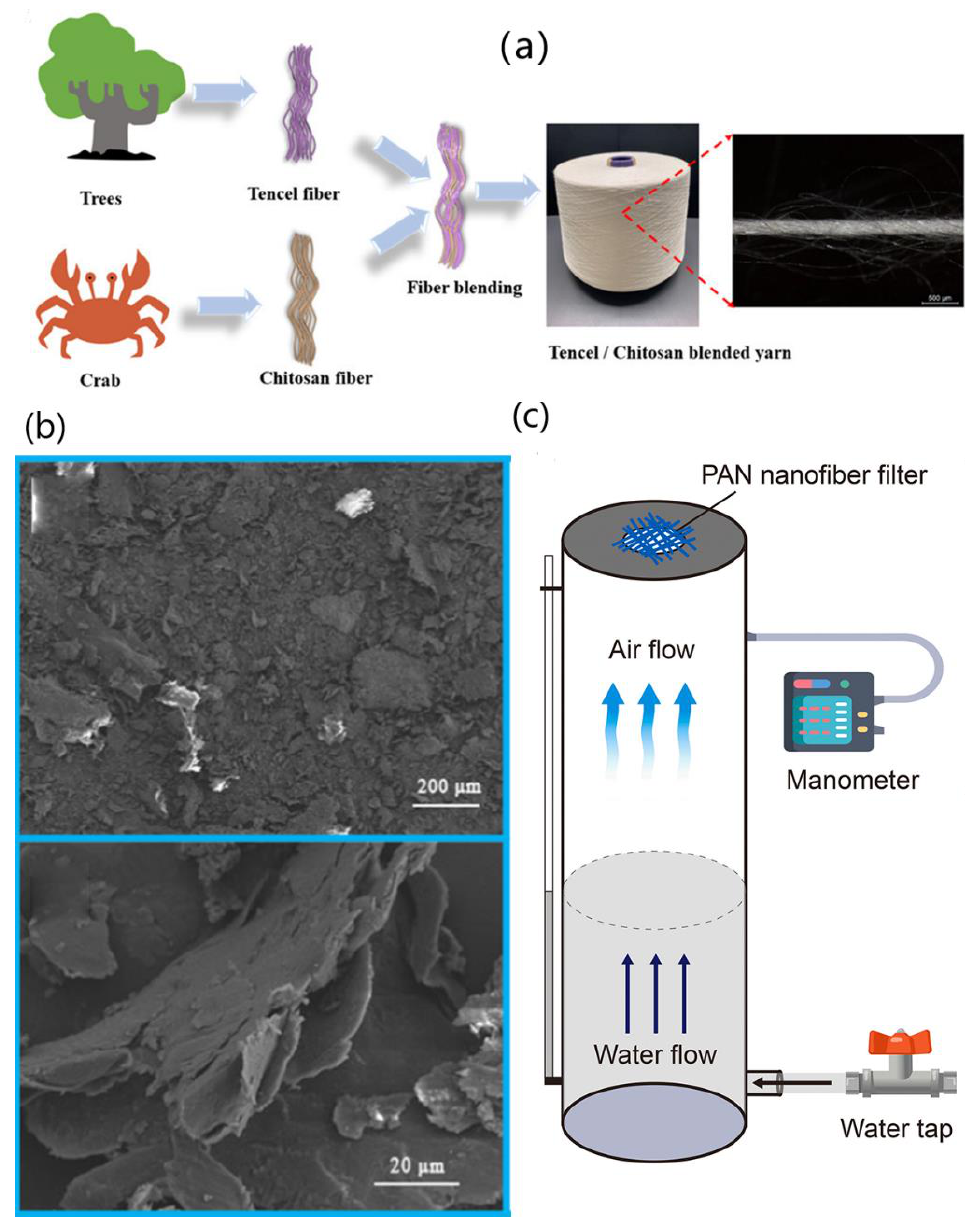
Figure 4. ( a ) Images showing the morphologies of the Tencel/chitosan yarn [53]; Copyright 2021, American Chemical Society. ( b ) SEM images of the surface of the fingernail power in different magnification [54]; Copyright 2020, Elsevier Ltd. (Amsterdam, The Netherlands). ( c ) Schematic illustration of the homemade pressure-drop testing setup [60]; Copyright 2021, Elsevier Ltd.